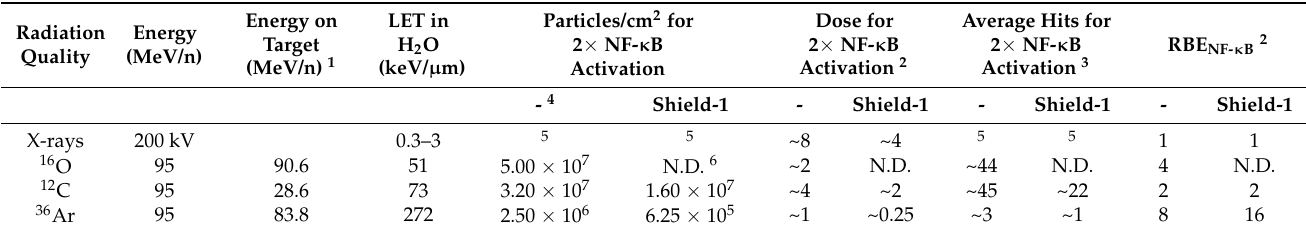
Table 1. Description of radiation qualities based on energy and linear energy transfer (LET), and dose and average hits per cell nucleus that are required for doubling of NF- κ B-dependent reporter gene expression above background.